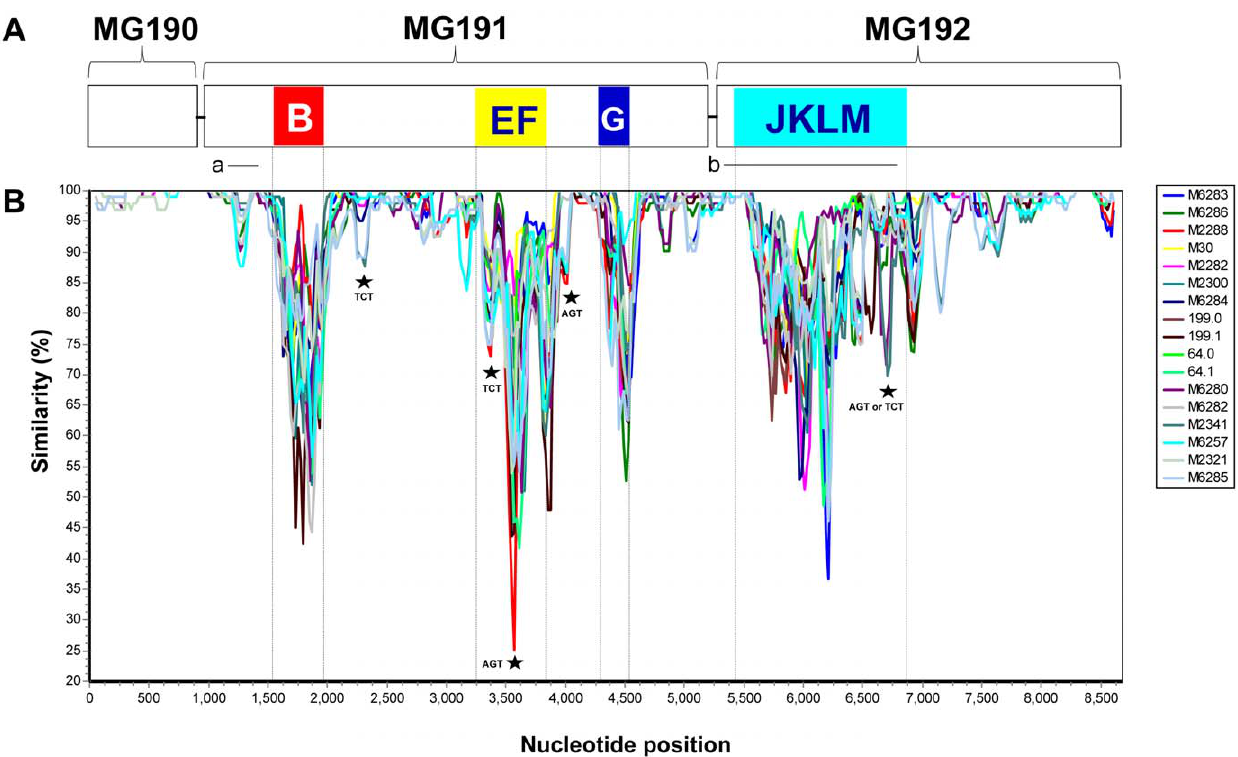
Figure 1. Sequence variability in the full-length MgPa operon of M.genitalium . ( A ) Schematic representation of the MgPa operon structure based on the G37 genome sequence (GenBank accession number NC_000908). Regions B, EF, G and JKLM highlighted in colors are referred to in the text as repeat regions, which are homologous to various parts of the nine MgPar regions scattered around the genome as shown in Fig. 2. The two horizontal bars labeled a and b represent the regions used as markers for the genotyping systems described by Hjorth et al . [14] and Musatovova et al . [26], respectively. ( B ) Similarity plot of the MgPa operon sequences from 15 M. genitalium strains as shown in the right. Each curve is a comparison between the strain being analyzed and G37. Each point plotted is the percent identity within a sliding window of 100 bp centered on the position plotted, with a step size between points of 20 bp. Dotted vertical lines indicate borders for the repeat regions. Stars indicate the location of variable trinucleotide tandem repeats, with the repeat units alongside the star. Details on these trinucleotide tandem repeats are to be reported elsewhere (Ma et al. , unpublished data).